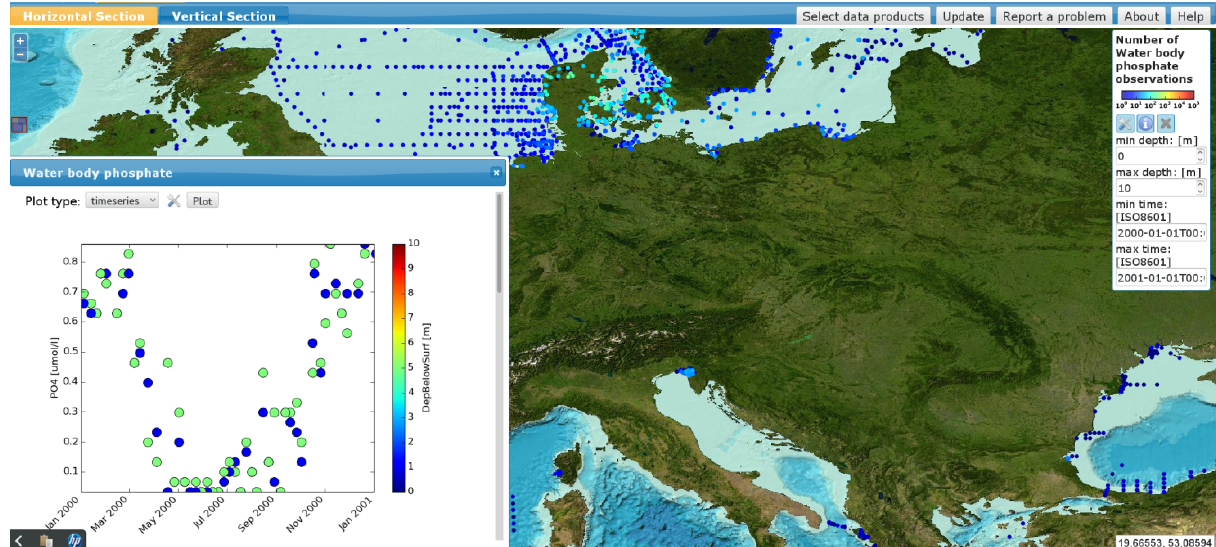
Figure 7. Screenshot from the web portal showing the time series dynamically plotted and visualized thanks to the OGC WPS